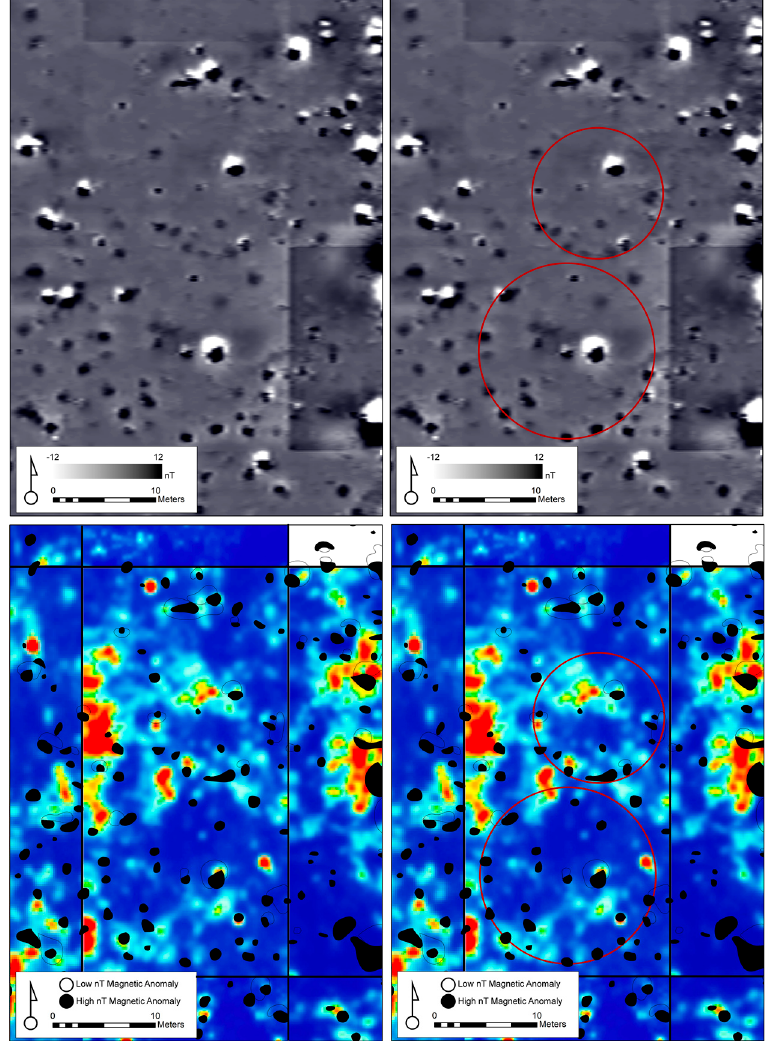
Figure 9. Two circular features identified in magnetic gradiometry ( top ) and GPR ( bottom ) data that possibly represent the remains of two post-Spanish occupation, native council houses.